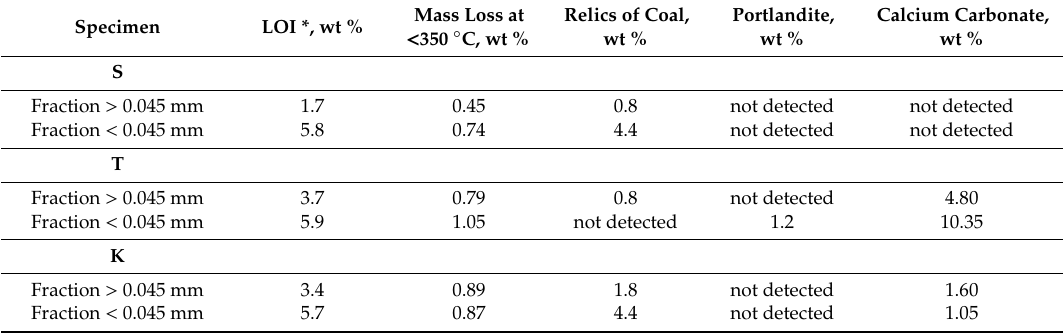
Table 6. Selected properties of CFBC fly ash separated for the fractions below and above 0.045 mm. Specimen LOI *, wt %